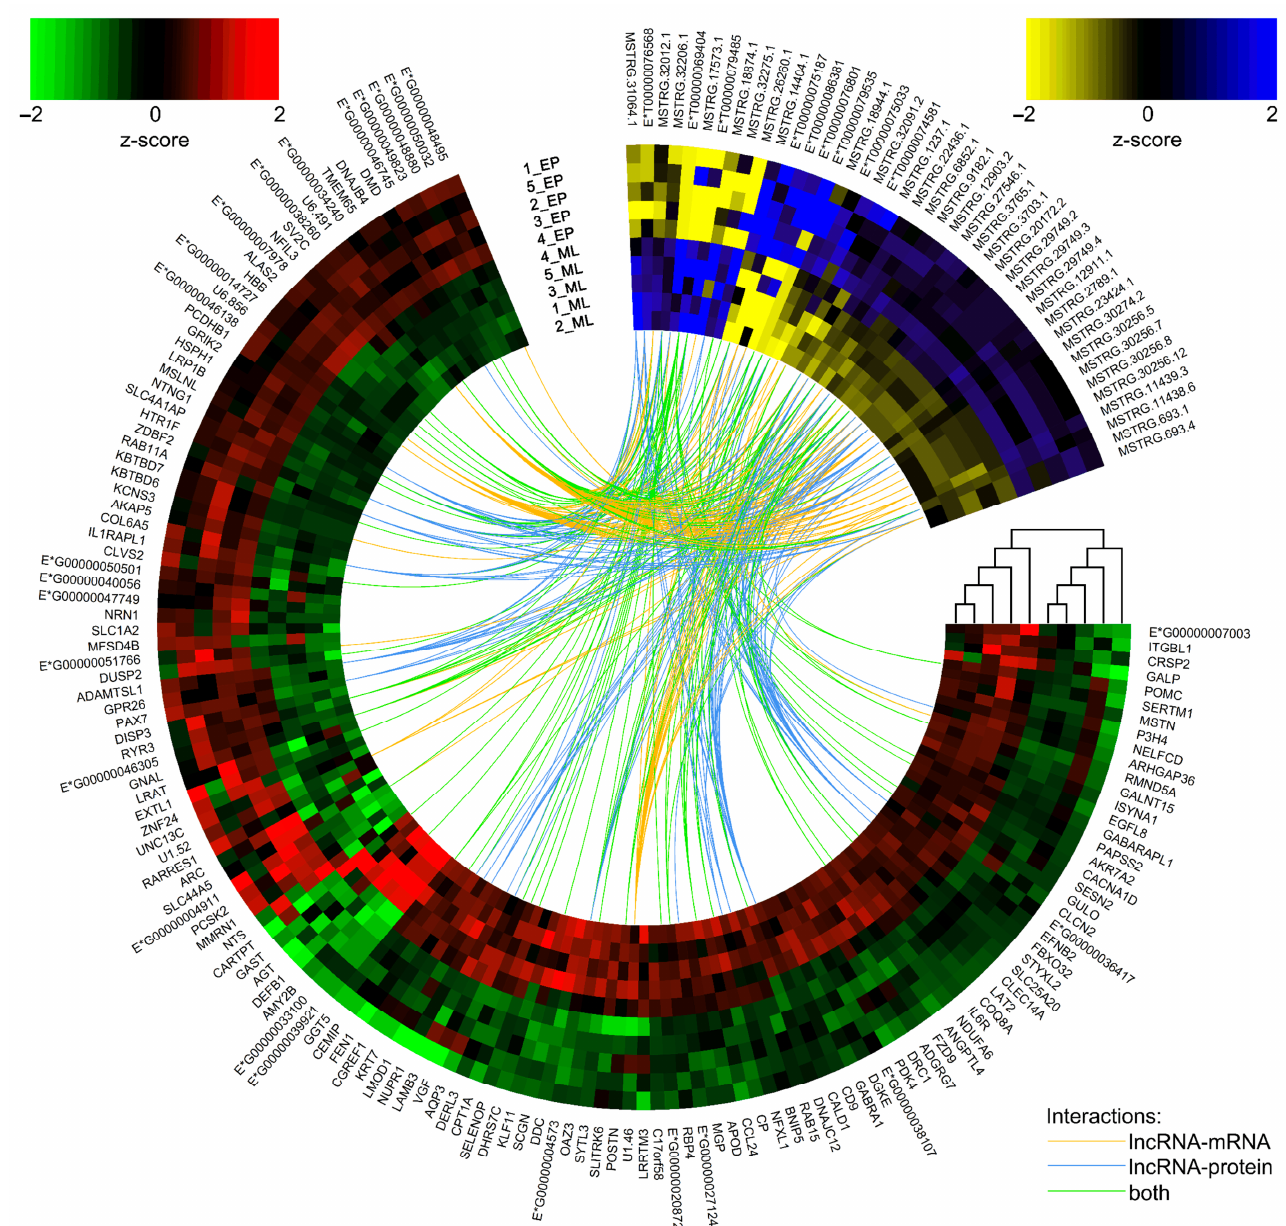
Figure 2. Visualization of trans -interactions occurring between differentially expressed protein-coding genes (DEGs) and differentially expressed long noncoding RNAs (DELs) within the porcine adeno- hypophyseal cells isolated during the embryo implantation pregnancy period (EP) in comparison to the mid-luteal phase of the estrous cycle (ML). Heatmaps show the expression profiles of DEGs (red–green) and DELs (blue–yellow). The sample layout in the heatmaps was created based on the DEGs cluster analysis, as shown using a dendrogram. Both DEGs and DELs were arranged according to increasing log 2 (fold change). Details of the interactions are provided in the text. The “NSSSC” fragments of Ensembl numbers were abbreviated with “*”.